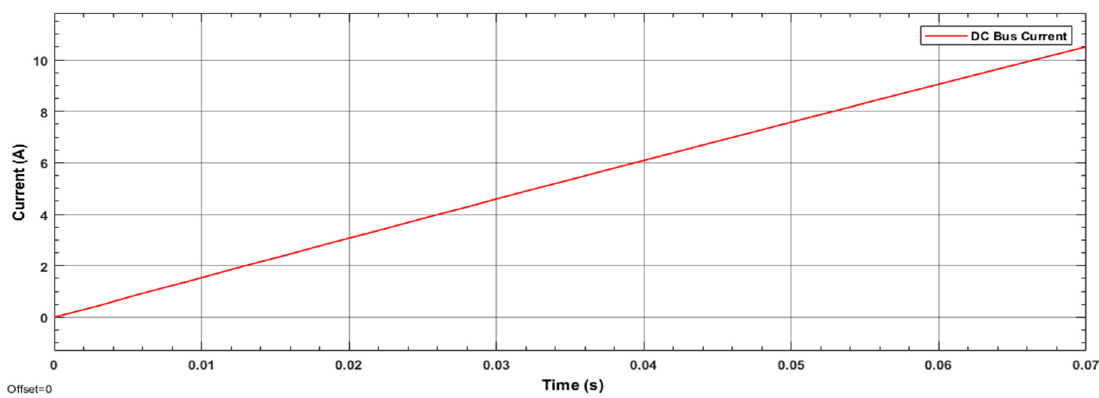
Figure 9. Boosted PEMFC output of DC bus.